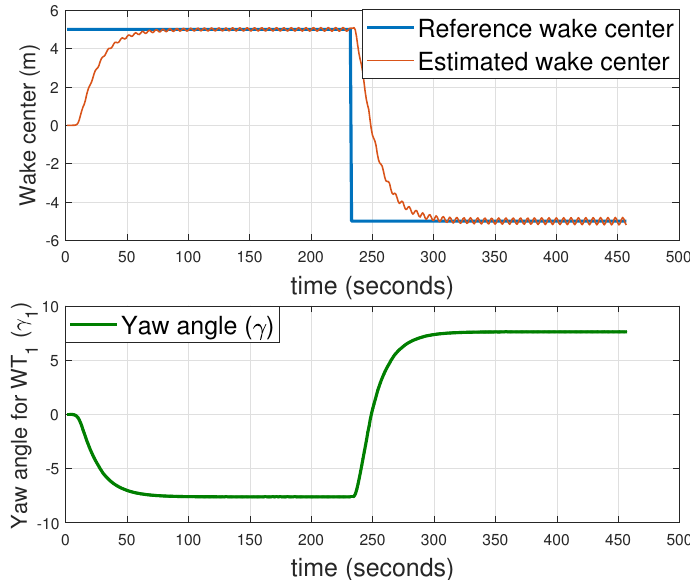
Figure 7. Estimated wake center and yaw angle alignment for model parameter k d = 0.15.